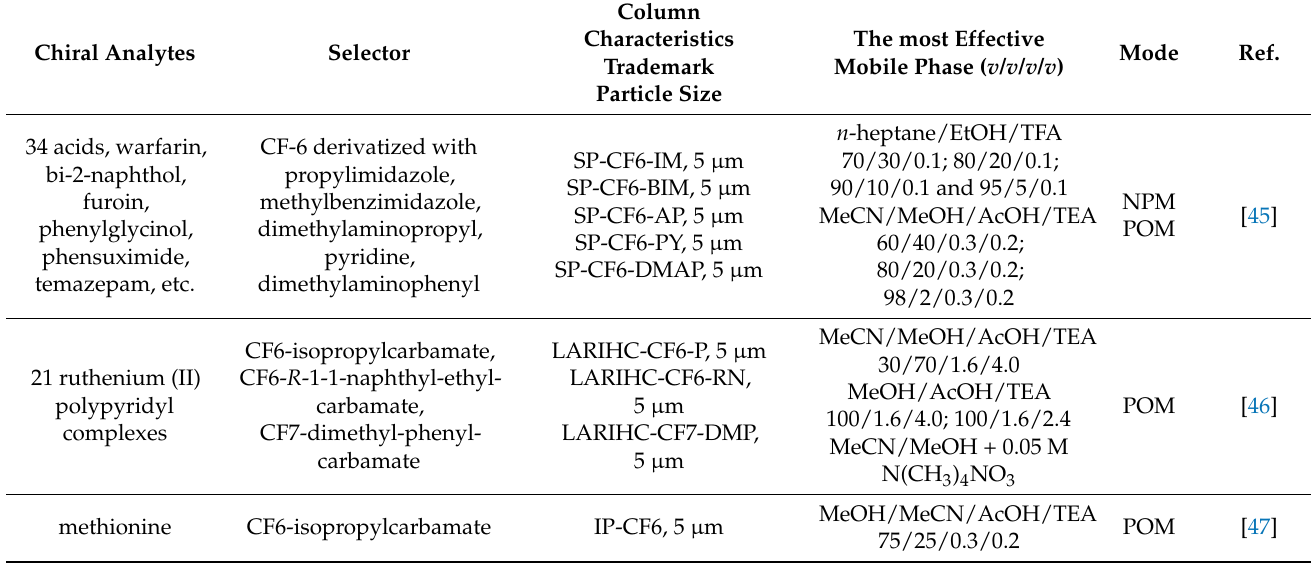
Table 3. High-performance liquid chromatographic enantioseparations on cyclofructan-based chiral stationary phases 1 . Chiral Analytes Selector